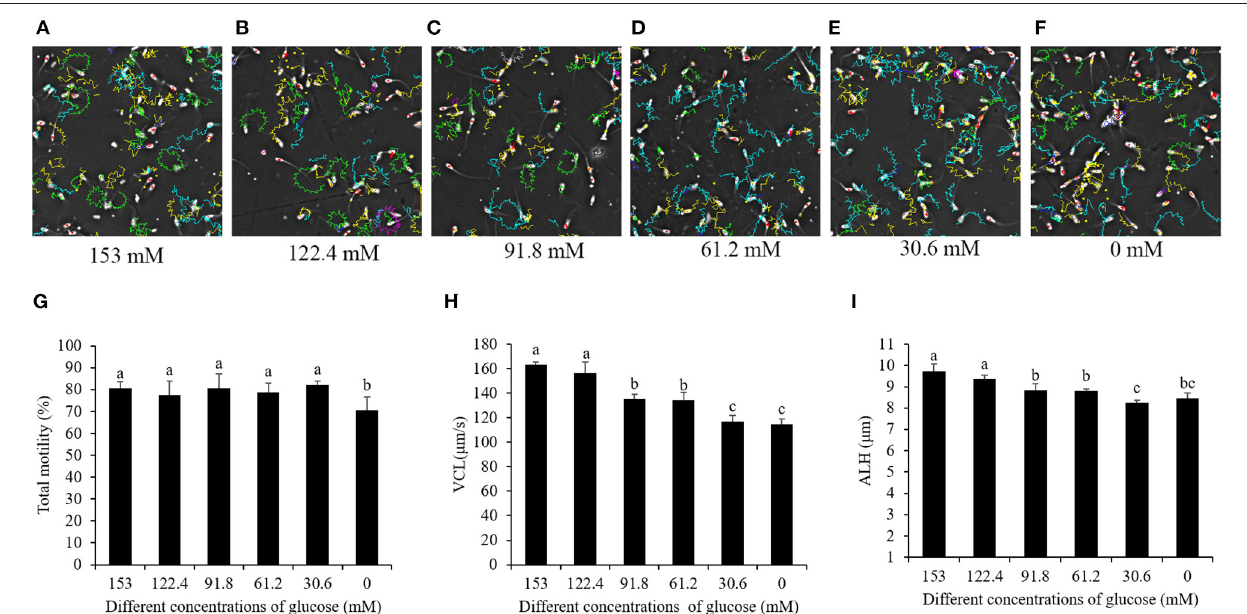
FIGURE 2 | Computer-assisted sperm motility analysis-derived changes in the sperm motility track by reducing the glucose level in the pretreatment solution from 153 to 0mM (A–F) . Effects of glucose level in the pre-treatment solution on sperm total motility (G) , VCL (H) , and ALH (I) during the cooling process. Values are specified as mean ± standard deviation. Columns with different lowercase letters differ significantly ( p < 0.05). VCL, curvilinear velocity; ALH, amplitude of lateral head